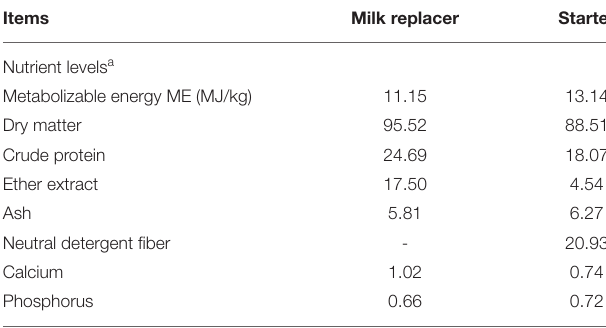
TABLE 1 | The nutrients levels of milk replacer and starter (air-dry basis, %).